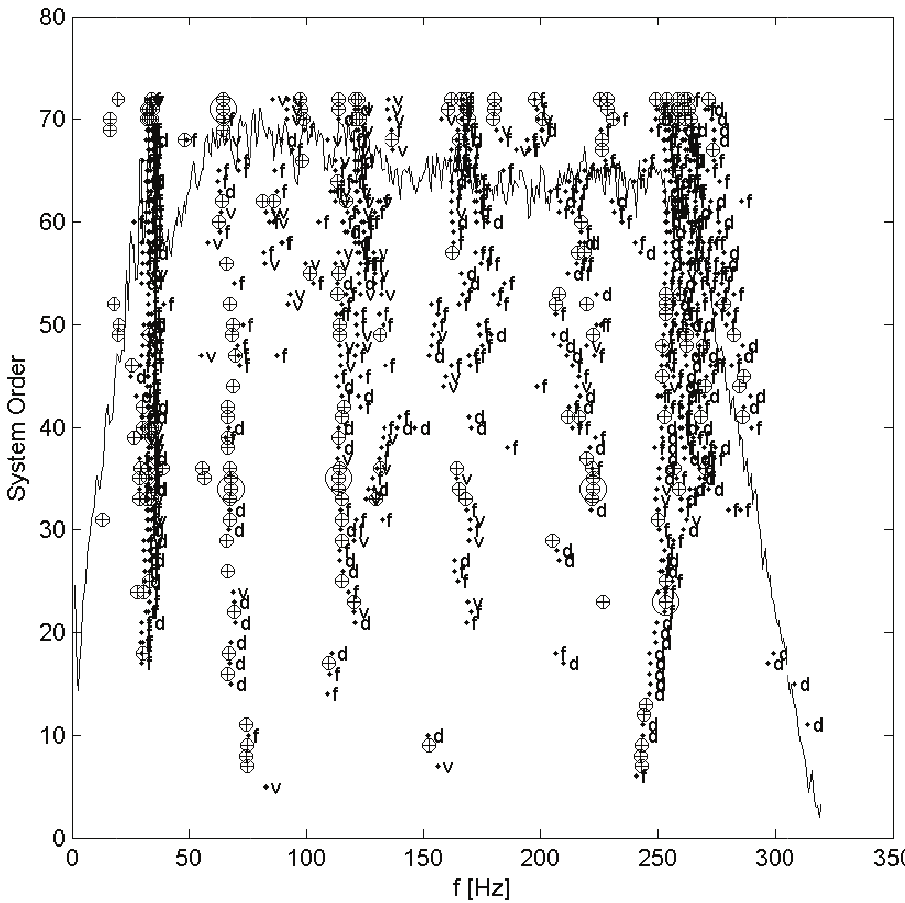
e 2. Stabiliz hair. (cid:1769)